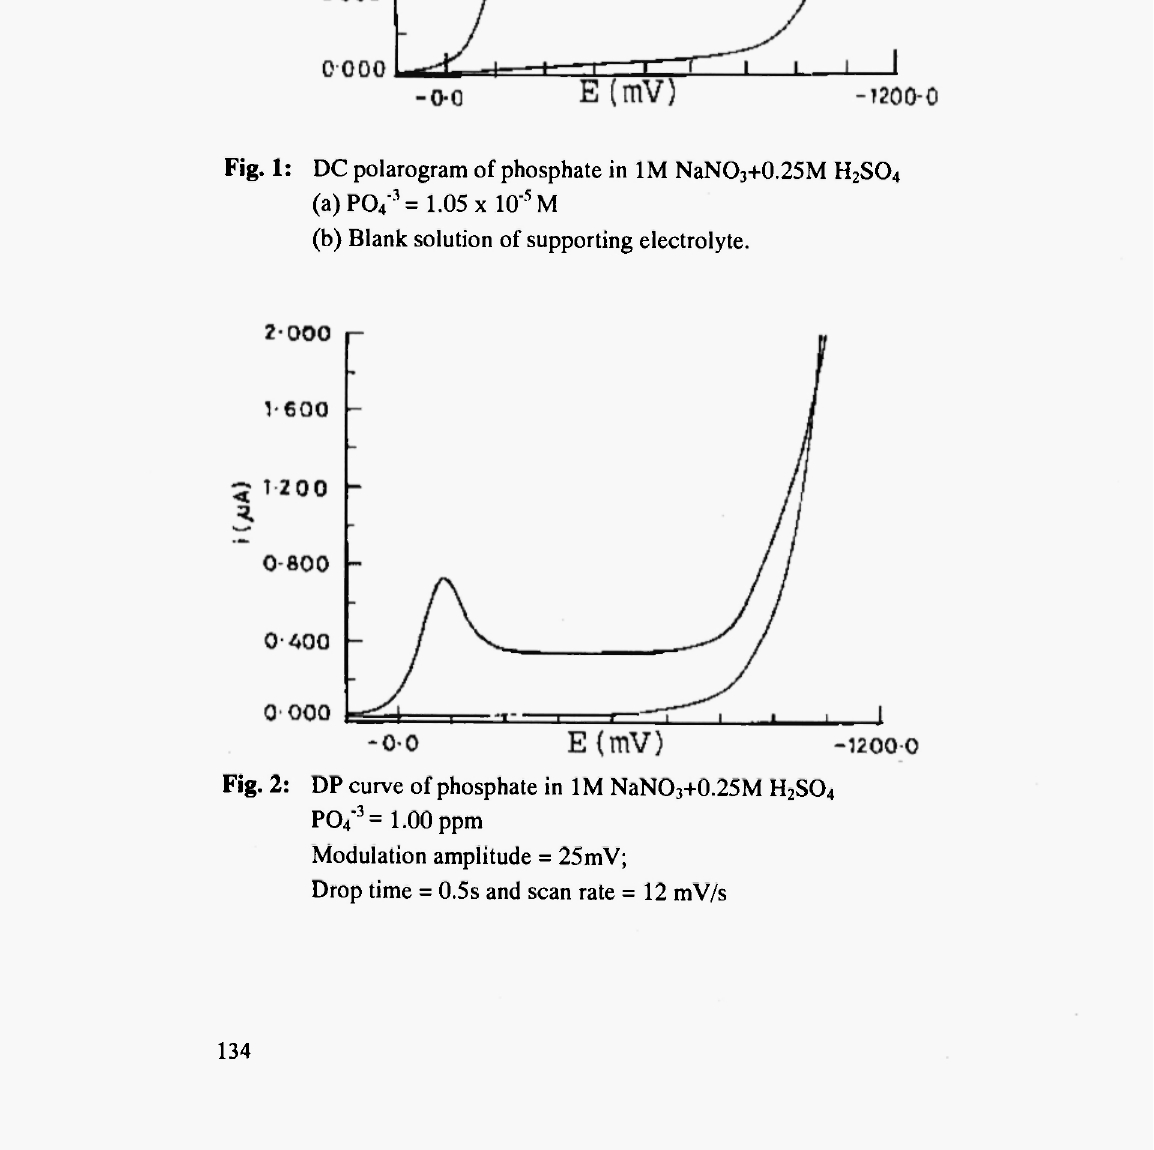
Fig. 1: DC polarogram of phosphate in 1M NaN0 3 +0.25M H 2 S0 4 (a) P0 4 " 3 = 1.05 χ 10" 5 Μ (b) Blank solution of supporting electrolyte.